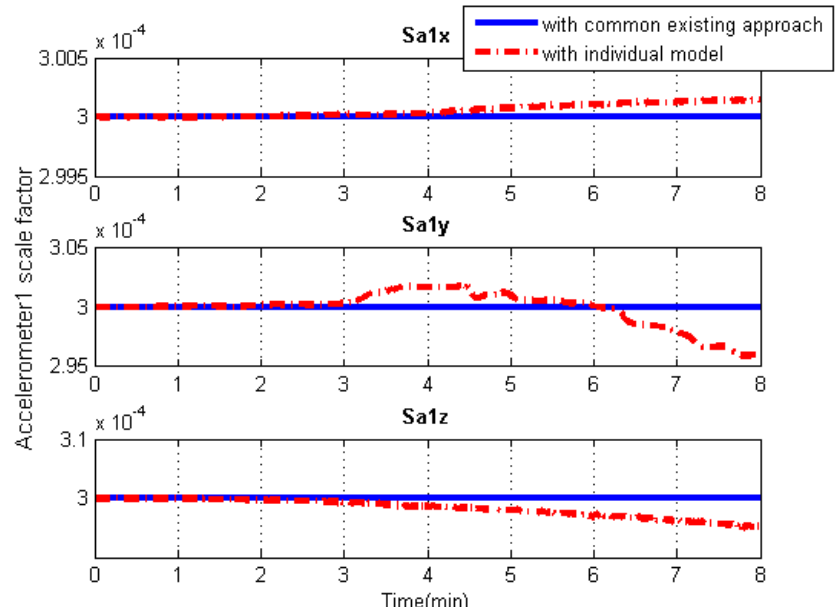
Figure 16. Accelerometer scale factor solution comparisons of the central IMU using the common existing approach or the individual modeling method.